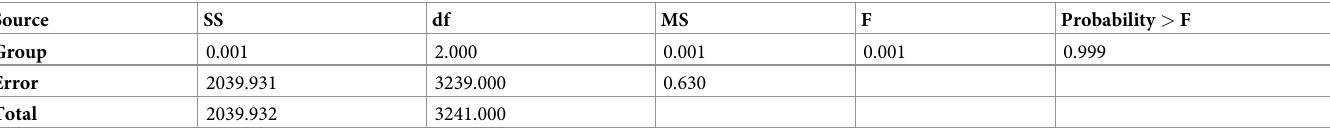
Table 2. One-way analysis of variance for pre-intervention attitudes toward IT innovations ( Q pre ) for the respondents themselves (Yourself). Source SS df MS F Probability > F Group 0.001 2.000 0.001 0.001